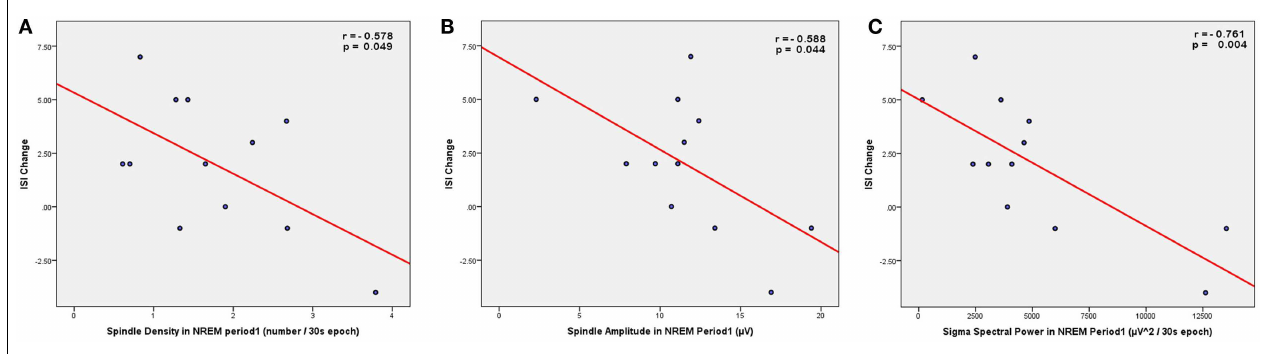
FIGURE 3 | Scatter plots showing the correlations between spindle parameters (A, density; B, amplitude) or sigma power (C) during NREM sleep period 1 (from C4–O2 EEG derivation) and the change in insomnia severity index (ISI) from the low stress to the high stress period